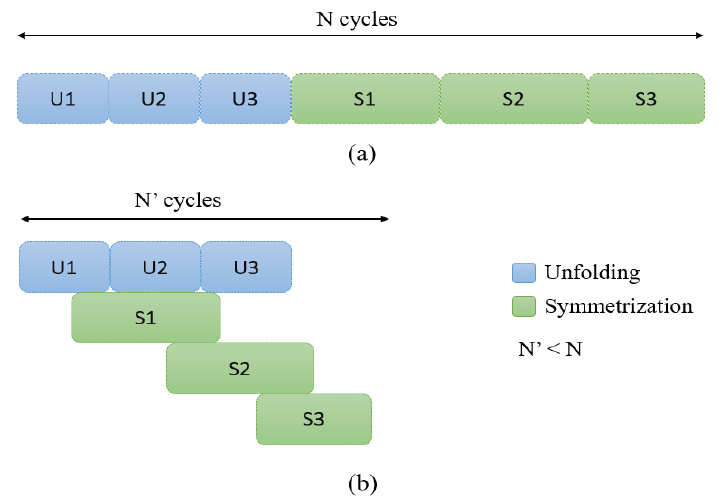
Figure 6. Dataflow pipelining: ( a ) without dataflow; and ( b ) with